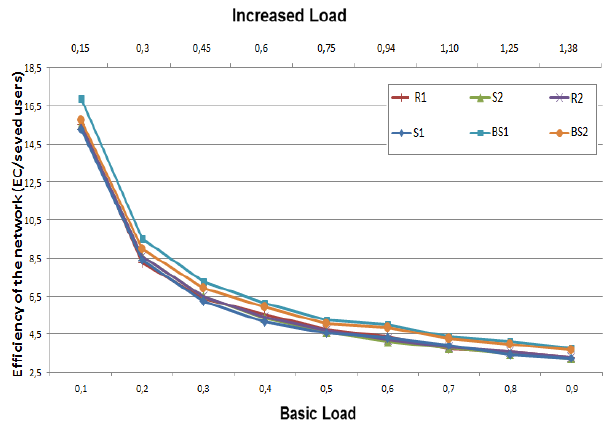
Figure 7: Efficiency of the network